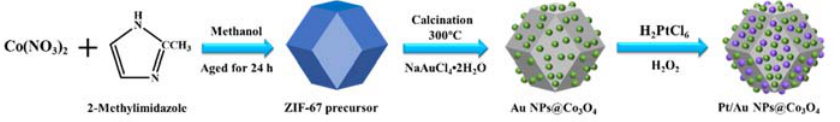
Figure 1. Schematic diagram of Pt/Au NPs@Co 3 O 4 synthesis .